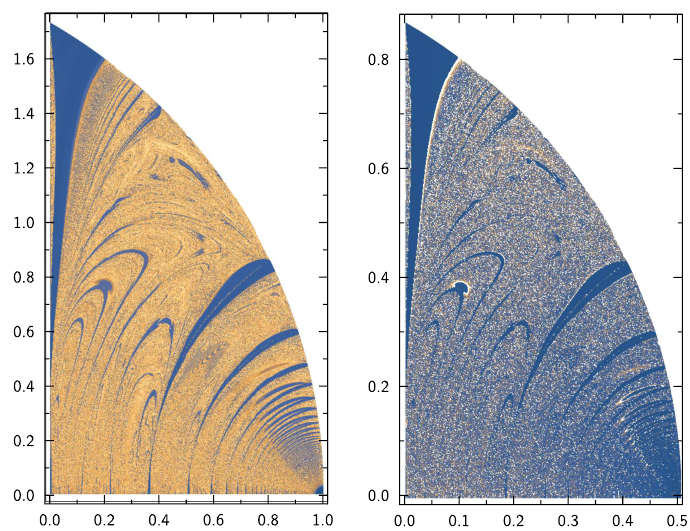
Fig. 6. Left: Shannon’s entropy for Method D in different parts of the Agekian- Anosova map are represented by different colors. Low values are shown in blue; high values are shown in light brown. Right: life-time of the system. Short- and long-lived systems are shown in blue and yellow, respectively. for binary encounters and the corresponding histogram. There are two distinct modes in the histogram. Fig. 8 shows the initial conditions corresponding to each of these modes. One can see that these two components are “complementary” in a way.